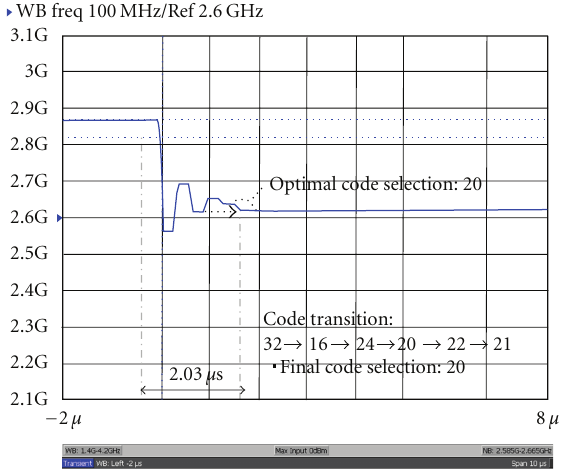
Figure 16: Measured VCO frequency during the VCO frequency calibration.